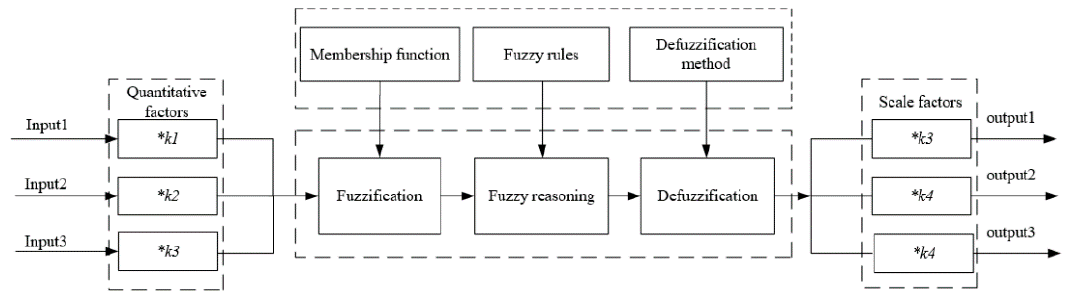
Figure 4. Structure of fuzzy optimization algorithm (FLA).